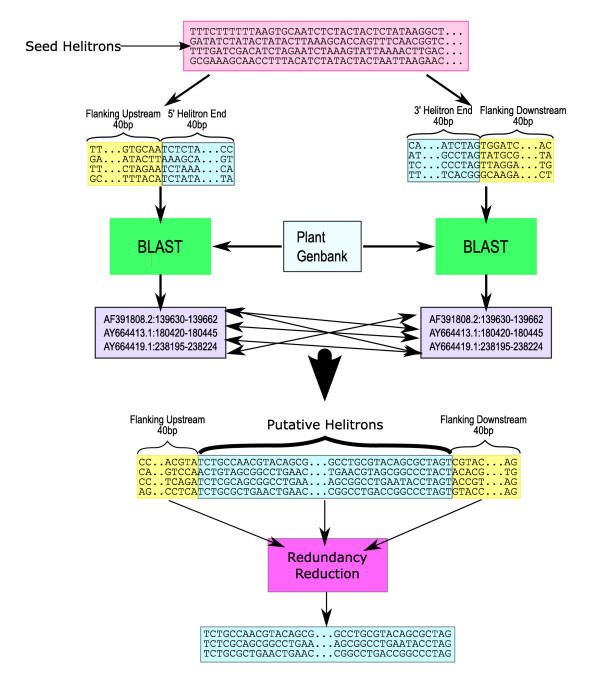
The identification algorithm. The flow chart diagrams the Blast-based approach used to identify helitron sequences initially. Approximately 40 bp were isolated from 5' and 3' ends of known helitrons, along with ~40 bp of flanking sequence. These ends were used as blast queries to Plant Genbank; hits to both ends that were <20,000 bp apart (represented by light blue-grey boxes with attaching arrows) were considered putative helitrons. These putative helitrons were screened for redundant or overlapping entries (pink box) to yield predicted helitrons. See Methods for details.